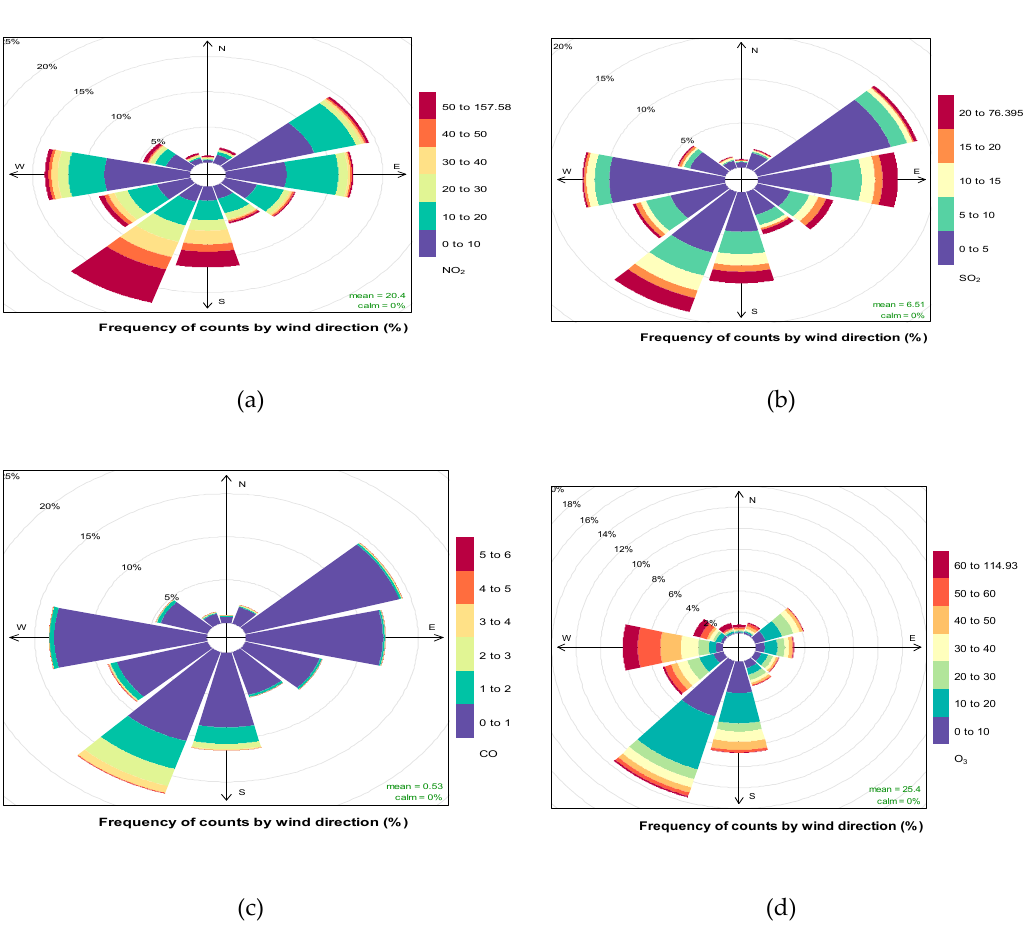
Figure 5 pollution roses NO 2 ( a ), SO 2 ( b ), CO ( c ), and O 3 ( d ). Figure 5. Pollution roses NO 2 ( a ), SO 2 ( b ), CO ( c ), and O 3 ( d